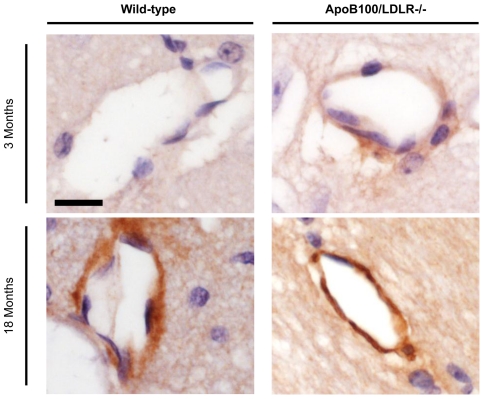
Aβ immunodetection in the cerebral vessels of young and aged wild-type and transgenic mice.Immunohistochemistry against Aβ of coronal sections from each of the age/genotype different groups. Scale bar: 11 µm.